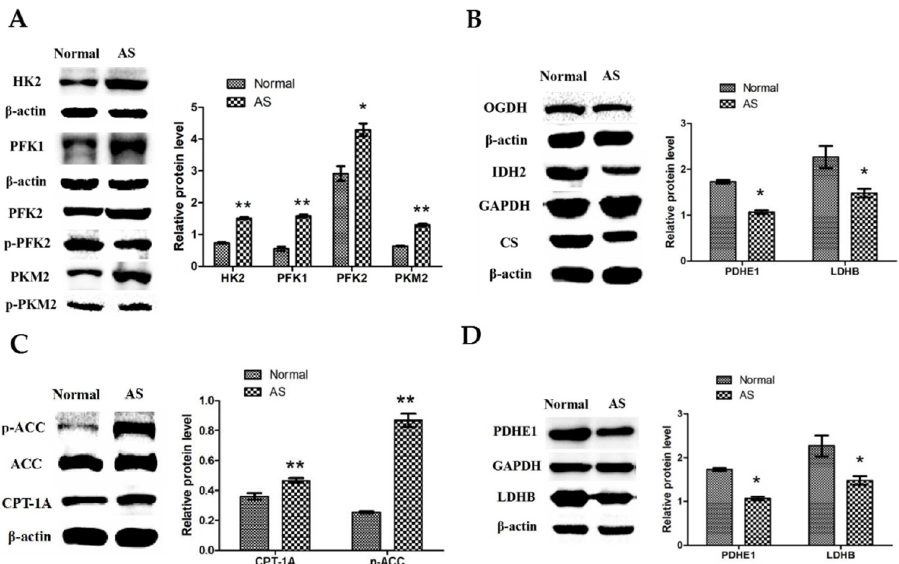
Figure 4. The protein expressions of key enzymes of the energy metabolic pathway of the myocardial tissues in ascitic broilers were measured using Western blotting: ( A ) the key enzymes PKM2, HK2, PFK1, and PFK2 in the glycolytic pathway of the ascitic broilers’ myocardial tissue; ( B ) the key enzymes OGDH, IDH2, and CS in the TCA cycle of the ascitic broilers’ myocardial tissue; ( C ) the key enzymes CPT-1A and p-ACC of the fatty acid oxidation pathway of the ascitic broilers’ myocardial tissue; ( D ) two important enzymes, PDHE1 and LDHB, of the glucose metabolism of the ascitic broilers’ myocardial tissue. The data are presented as means ± SEM. The experiment was repeated three times independently. * p < 0.05 and ** p < 0.01 indicate a significant difference from the control group.